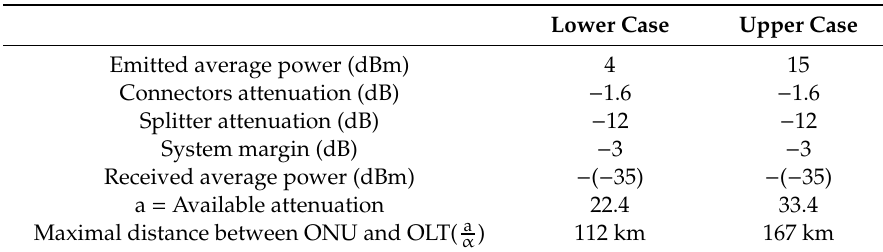
Table 3. Budget power calculation.